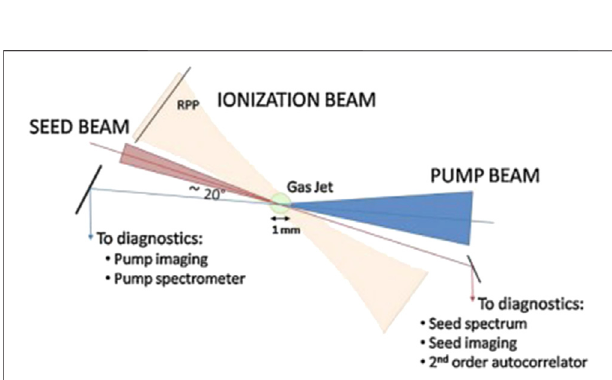
FIGURE 10 | Experimental scheme showing the three laser beams focused at the center of a supersonic gas jet [96].